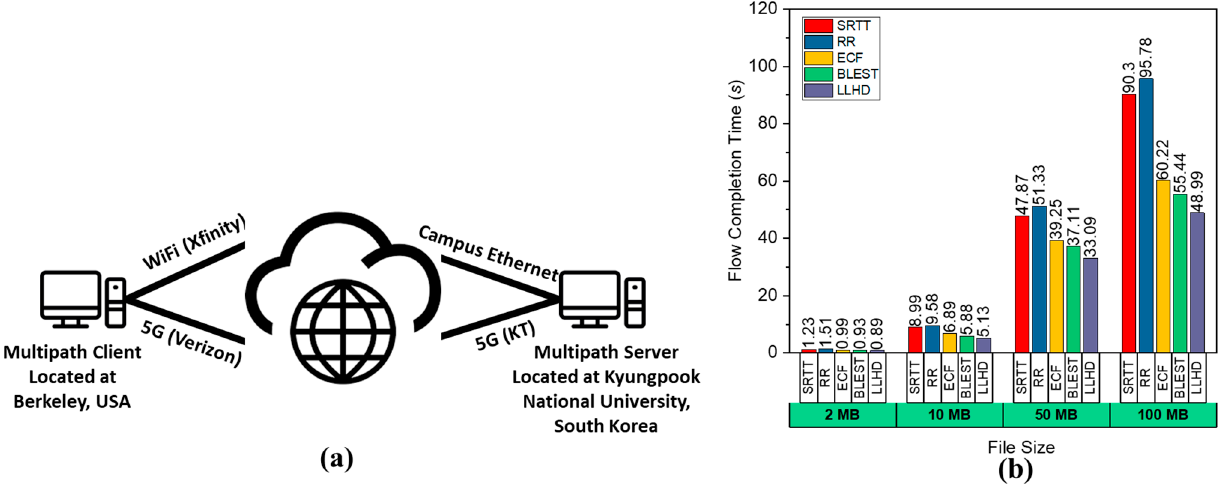
Figure 6. Performance evaluation of the considered schedulers in a real-world experiment: ( a ) real-world test setup and ( b ) observed FCT.